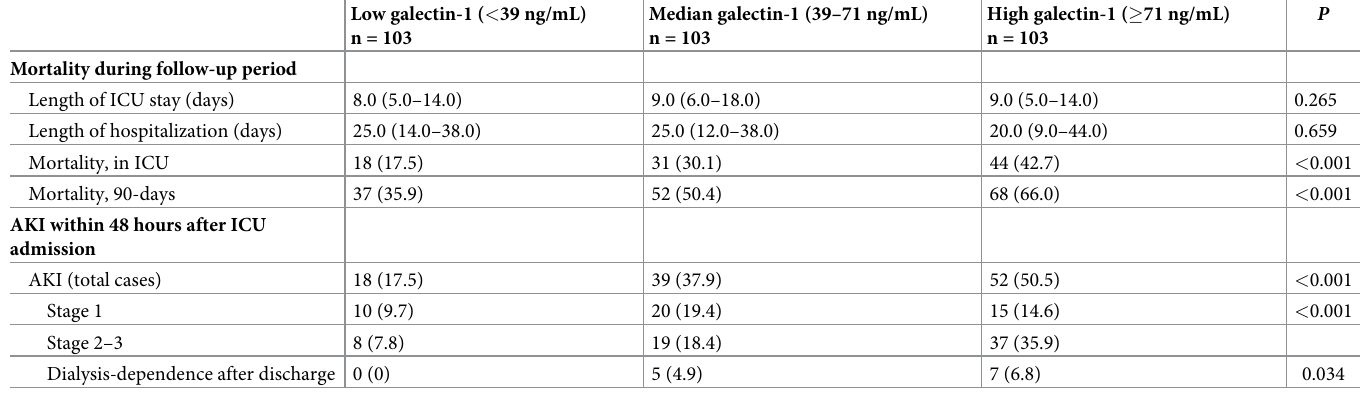
Table 2. Clinical outcomes of critically ill patients grouped by serum galectin-1 concentrations.